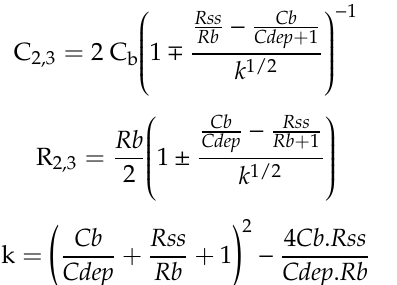
Figure 7. Equivalent circuit models of biochip without analyte ( a ) based on the physiochemical structure of biochip and ( b ) based on the associated RC pairs. The parallel capacitor C 2 and resistor R 2 are transferred from C dep and Rss. Equivalent circuit models of biochip with analyte ( c ) in Maxwell fashion and in ( d ) Voigt fashion. The Voigt fashion can be transferred into Maxwell fashion while using Equations (1)–(3).